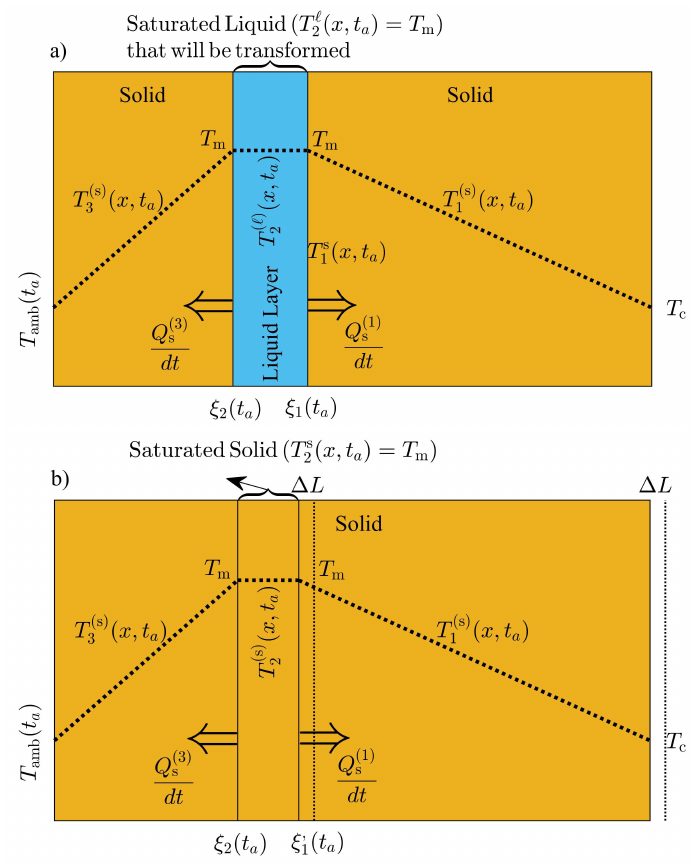
Figure 5. Solid phase formation during the collision of ξ 1 ( t ) and ξ 2 ( t ) . ( a ) Saturated liquid layer before the phase transition at some time t = t a . ( b ) PCM layer contraction ∆ L = L ( t a ) − L (cid:48) ( t a ) after the phase transition. The exterior surface is pulled to the left due to volume changes produced by the difference between solid and liquid